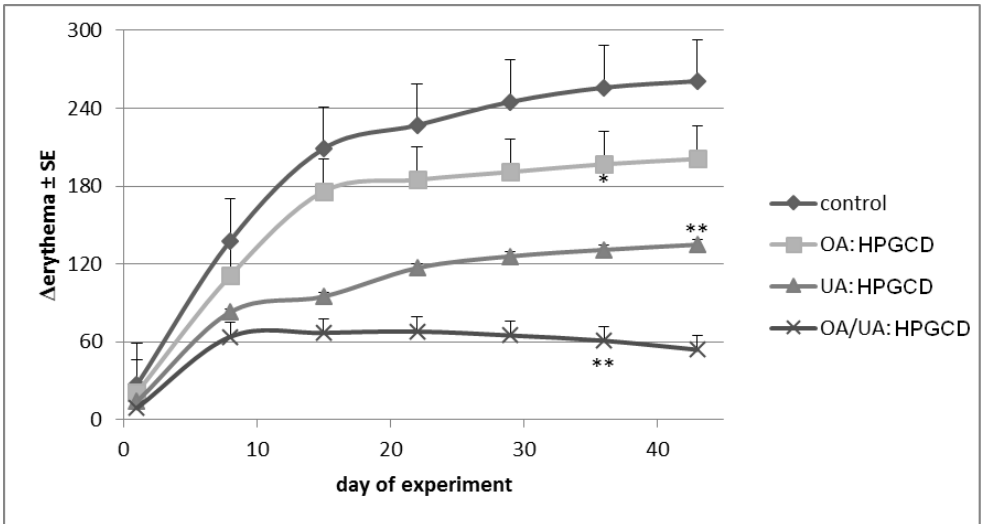
Figure 11. Erythema progress.